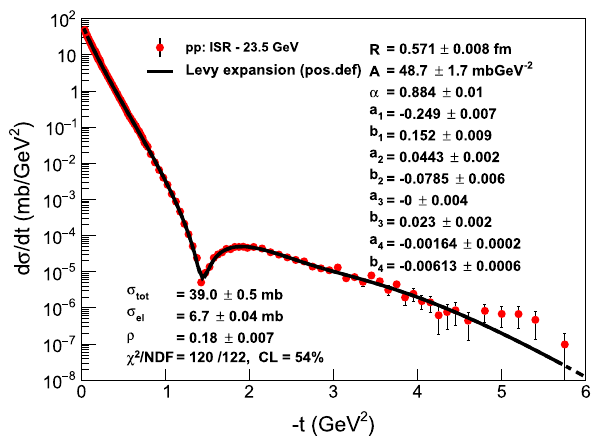
Fig. 20 Fourth-order Lévy expansion fits of the differential cross- section data from Ref. [45] on pp elastic scattering at GeV